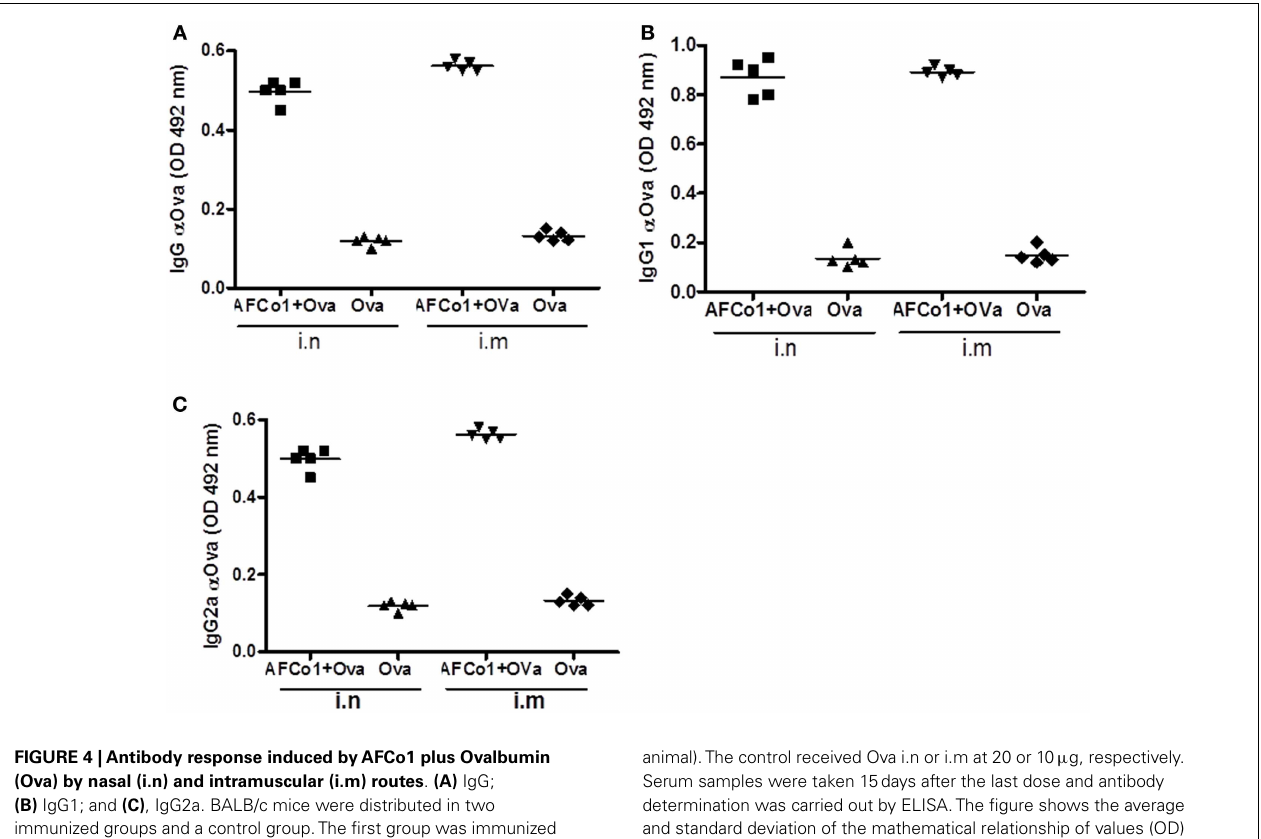
FIGURE 4 |Antibody response induced byAFCo1 plus Ovalbumin (Ova) by nasal (i.n) and intramuscular (i.m) routes . (A) IgG; (B) IgG1; and (C) , IgG2a. BALB/c mice were distributed in two immunized groups and a control group.The first group was immunized with three i.n doses (0, 7, 14days) of AFCo1 + Ova (25 µ g/20 µ g in 25 µ L, 12.5 µ L through each nostril).The second was treated with two i.m doses (0, 14days) of AFCo1 + Ova (12.5 µ g/10 µ g in 50 µ L per